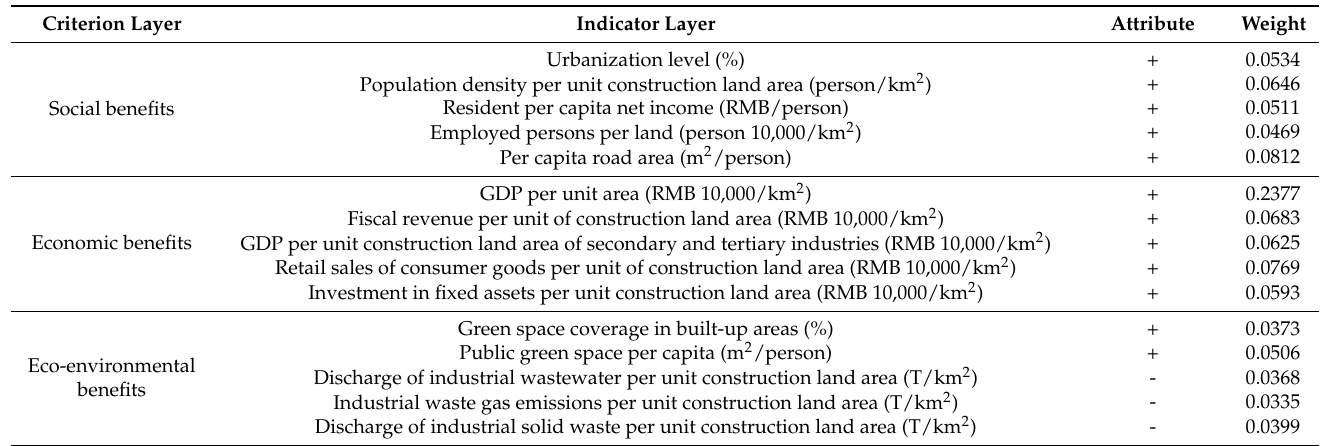
Table 1. Three-dimensional framework evaluation index system of